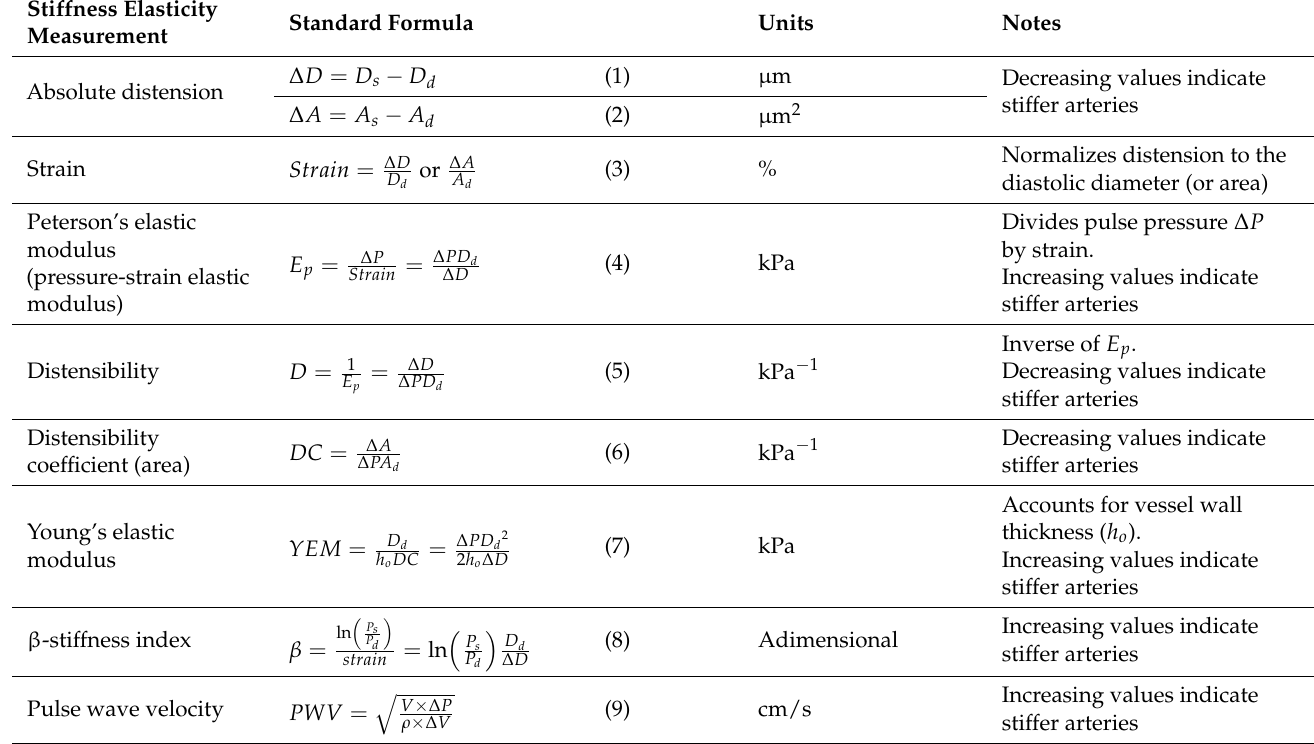
Table 2. Parameters used to express local elasticity and stiffness of blood vessels, as a function of changes in diameter or area of those vessels during cardiac cycle (systolic and diastolic). Adapted from